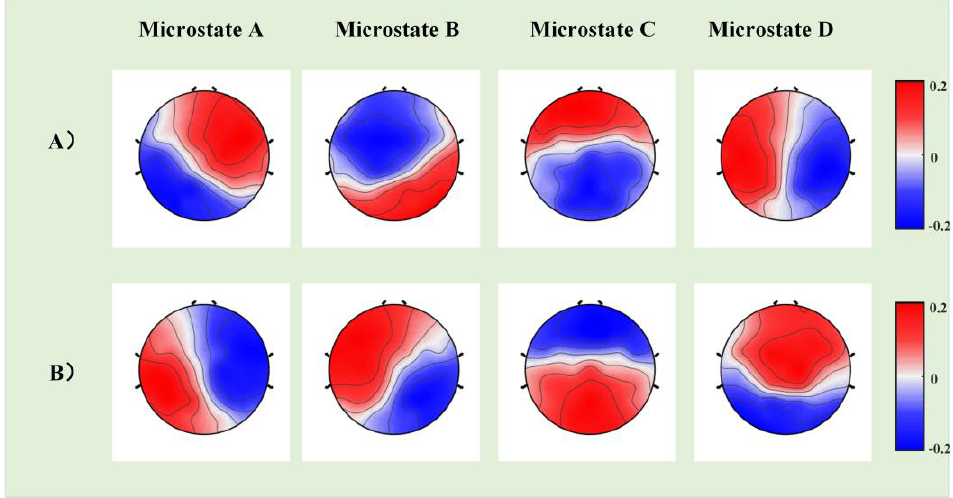
Figure 2. The group-level template maps of the four microstate classes. ( A ) The microstate template map in the autism spectrum disorder (ASD) group ( n = 26). ( B ) The microstate template map in the typical development (TD) group ( n = 26).